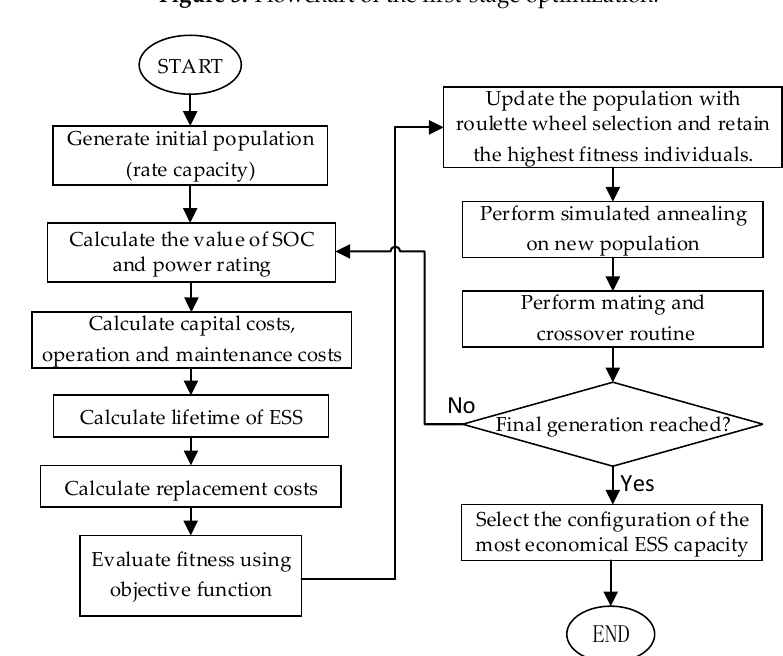
Figure 3. Flowchart of the first-stage optimization.